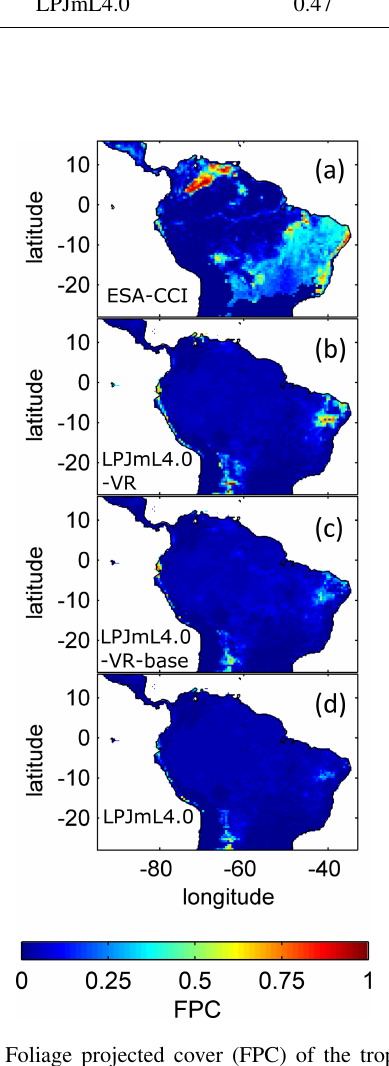
Figure B8. Foliage projected cover (FPC) of the tropical herba- ceous PFT over the study region. (a) Satellite-derived vegetation composition from ESA Land Cover CCI V2.0.7 (Li et al., 2018) reclassified to the PFTs of LPJmL as in Forkel et al. (2014). (b) LPJmL4.0-VR. (c) LPJmL4.0-VR-base. (d) LPJmL4.0. All LPJmL model versions were forced with CRU climate input. The FPC shown for all models refers to 2001–2010.